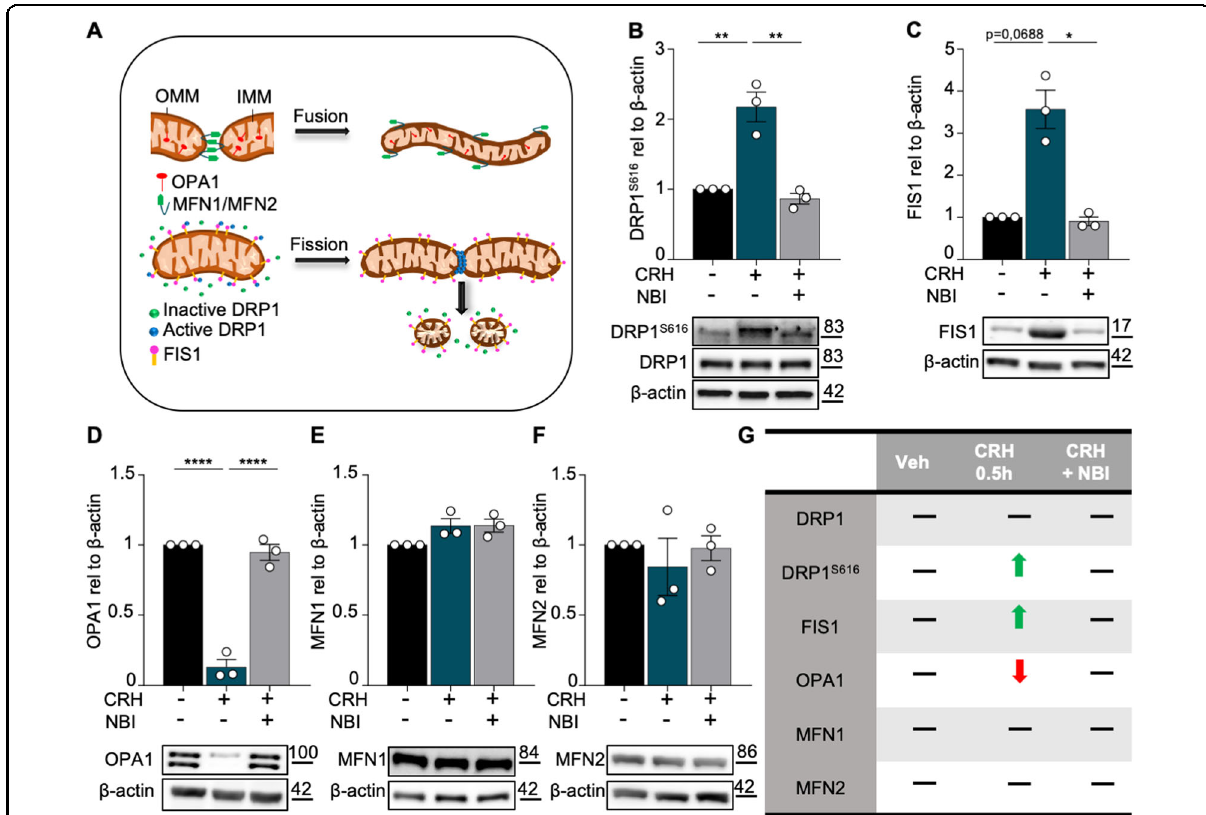
Fig. 6 CRH induces mitochondrial fi ssion. A Graphical representation of mitochondrial dynamic: fusion and fi ssion with relative proteins (OMM = outer mitochondrial membrane; IMM = inner mitochondrial membrane). Primary hippocampal neurons at DIV14 were treated with CRH 100 nM for 0.5 h and with CRH 0.5 h + CRHR1 Blocker NBI30775 100 nM; Western Blot analysis and quanti fi cation of B the fi ssion proteins DRP1 S616 , C FIS1 and the fusion markers D OPA1, E MFN1 and F MFN2. G Summary of the western blot results. Experiments were performed in N = 3 independent replicates at DIV14. Data are displayed as Mean ± SEM; one-way ANOVA and Bonferroni ’ s post hoc comparison test were performed; data non normally distributed were analyzed by Kruskal – Wallis non parametric test followed by Uncorrected Dunn ’ s multiple comparison test. ( *p < 0.05, **p